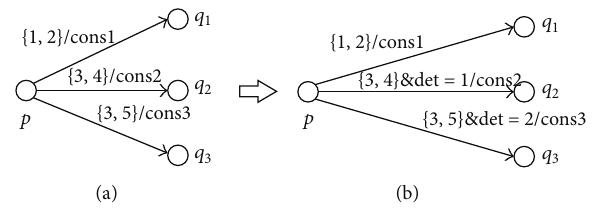
Figure 3: Assertion graph